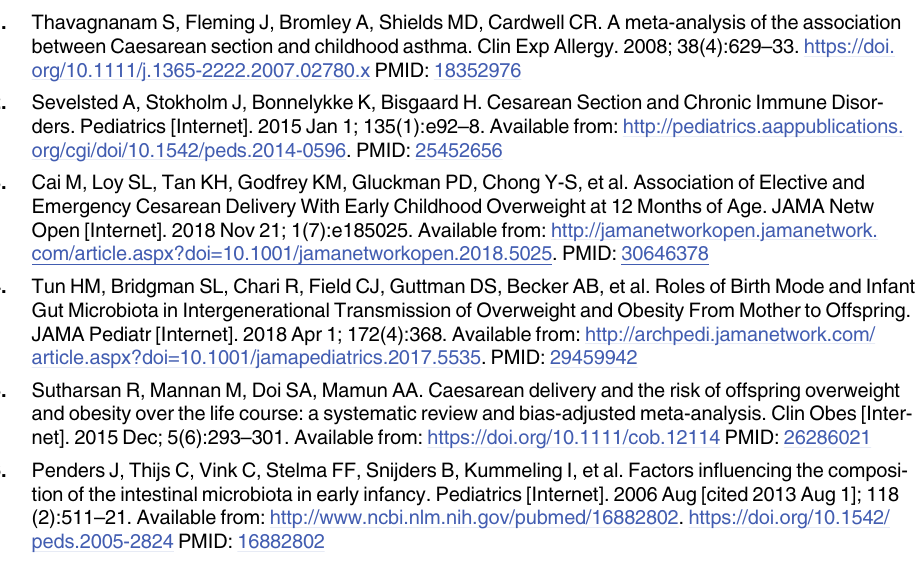
S2 Table. Primers used for the qPCR quantification of the main genera and species obtained from the infant fecal